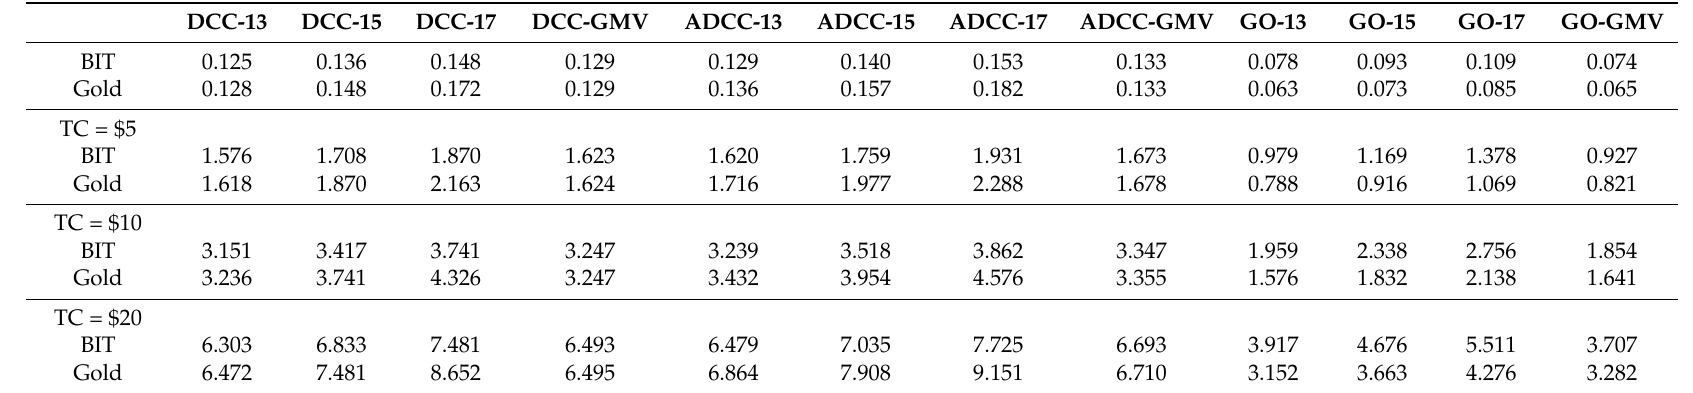
Table 7. Turnover and trading